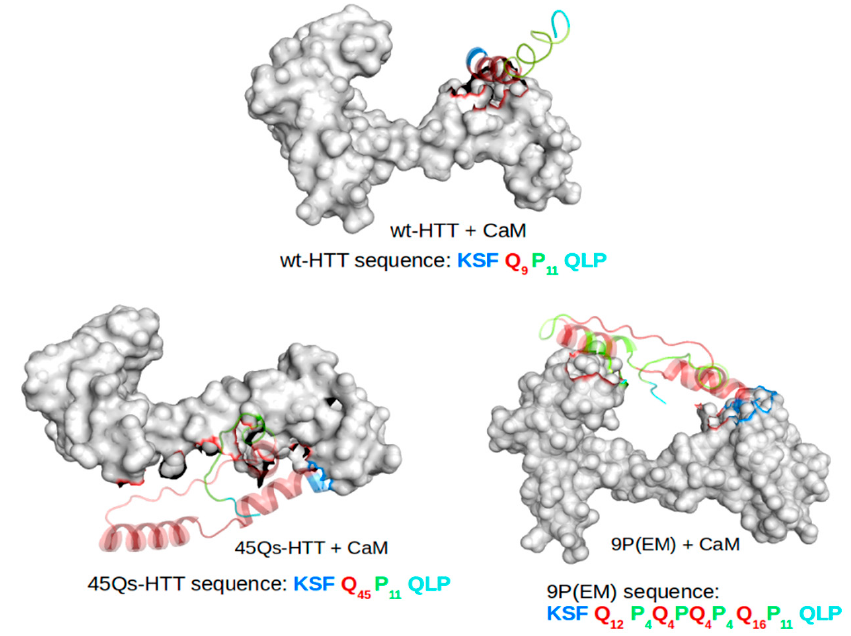
Figure 2. The resulted docked positions for CaM ‐ HTT complexes.